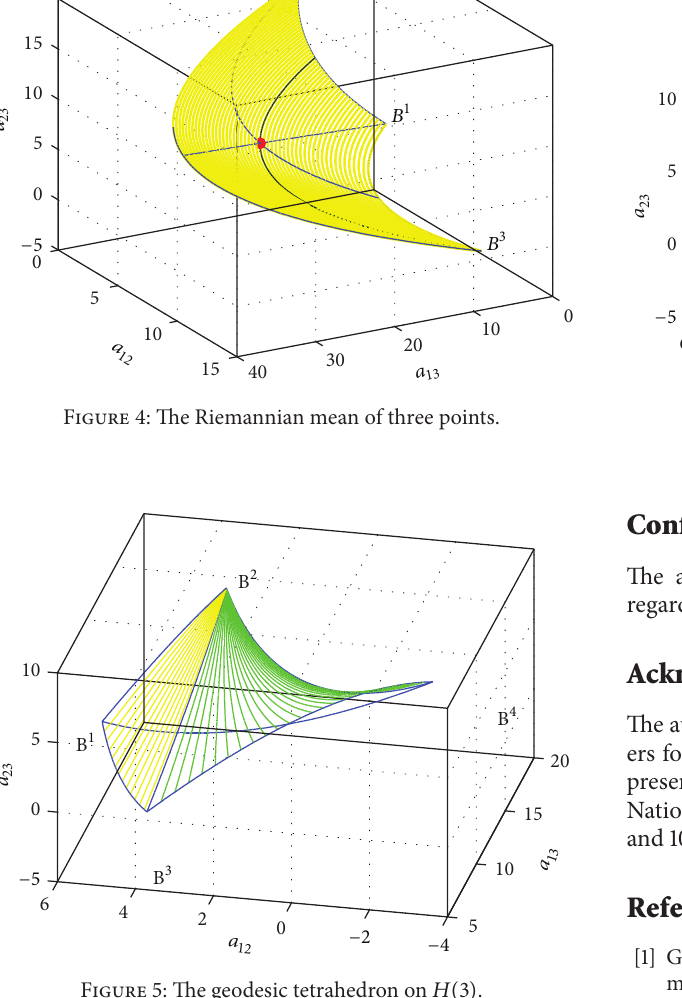
Figure 5: The geodesic tetrahedron on 𝐻(3) .